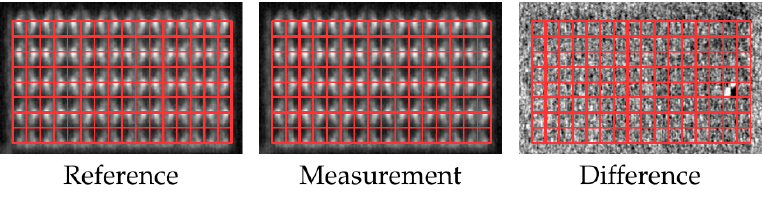
Figure 12: Difference calculation between an “all bits zero” TLS reference and measurement data quickly reveals which bits are set in the AES key. As an example the right-hand half of the BBRAM with a single bit set (bit 126) is shown